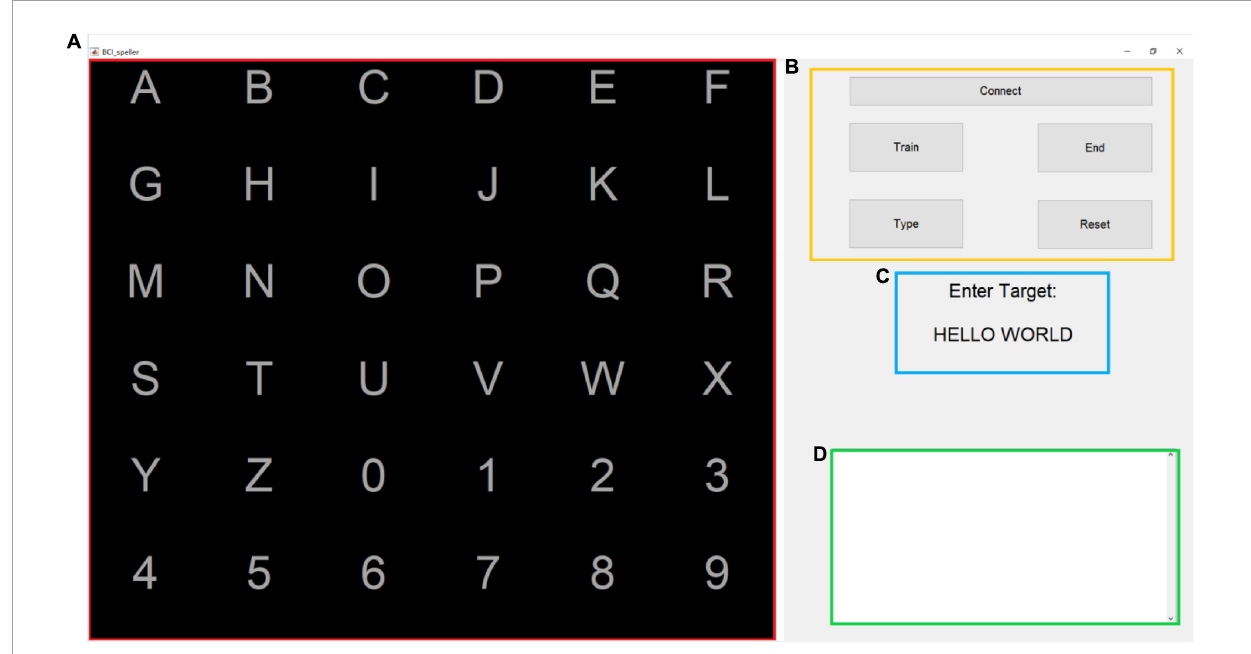
FIGURE5 The graphical user interface used by the hybrid speller system. The area marked in red (A) is the visual stimulus interface; the area marked in yellow (B) is the control panel; the area marked in blue (C) is the input target prompt text box, and the area marked in green (D) is the input text box.